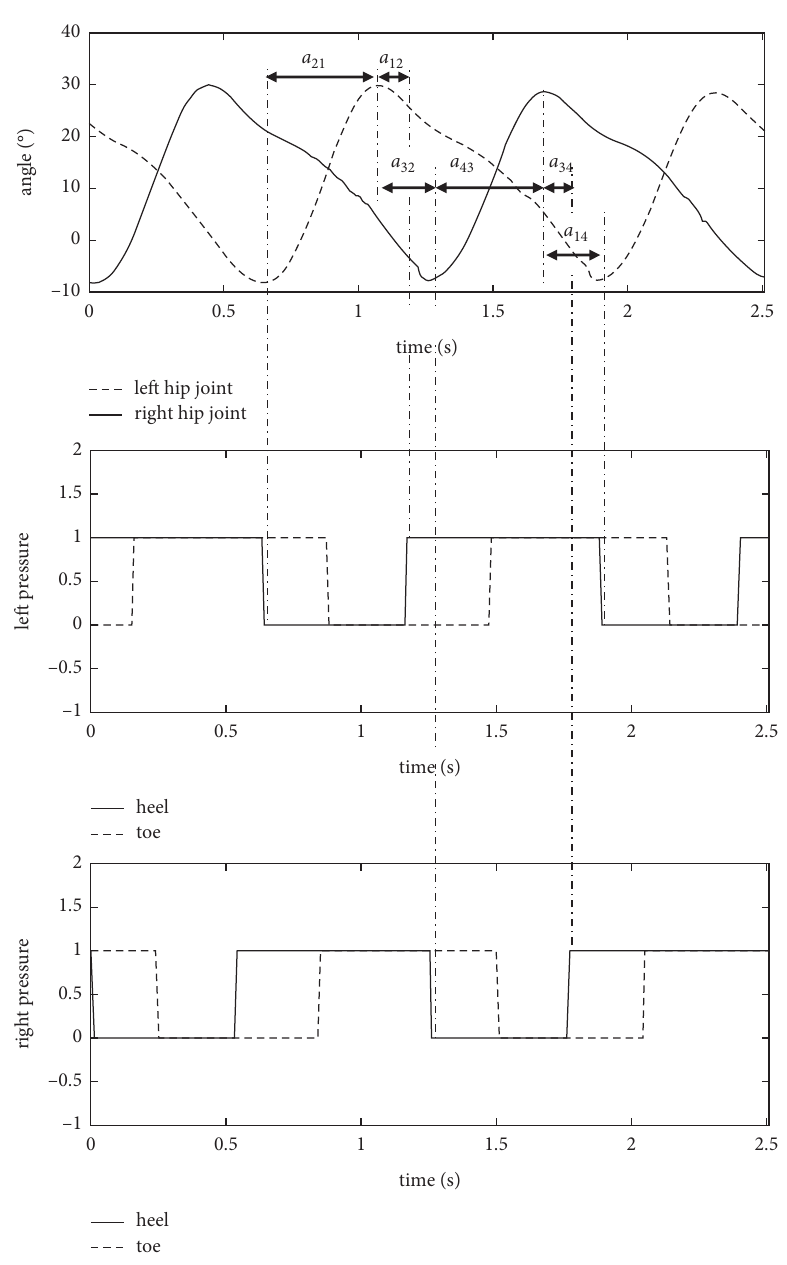
Figure 3: The time of each walking